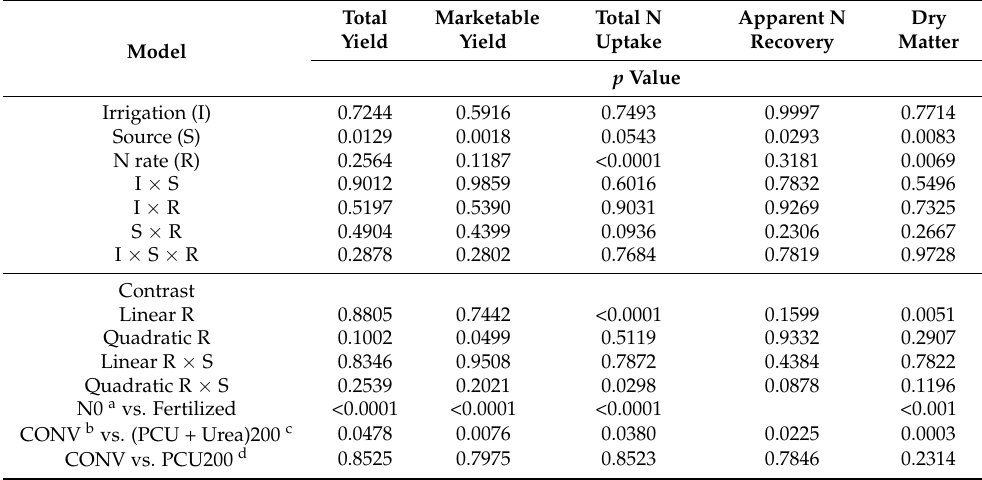
Table 4. Analysis of variance of the effect of fertilizer N rate and source, and irrigation on total yield, marketable yield, total N uptake, apparent N recovery, and aboveground dry matter.